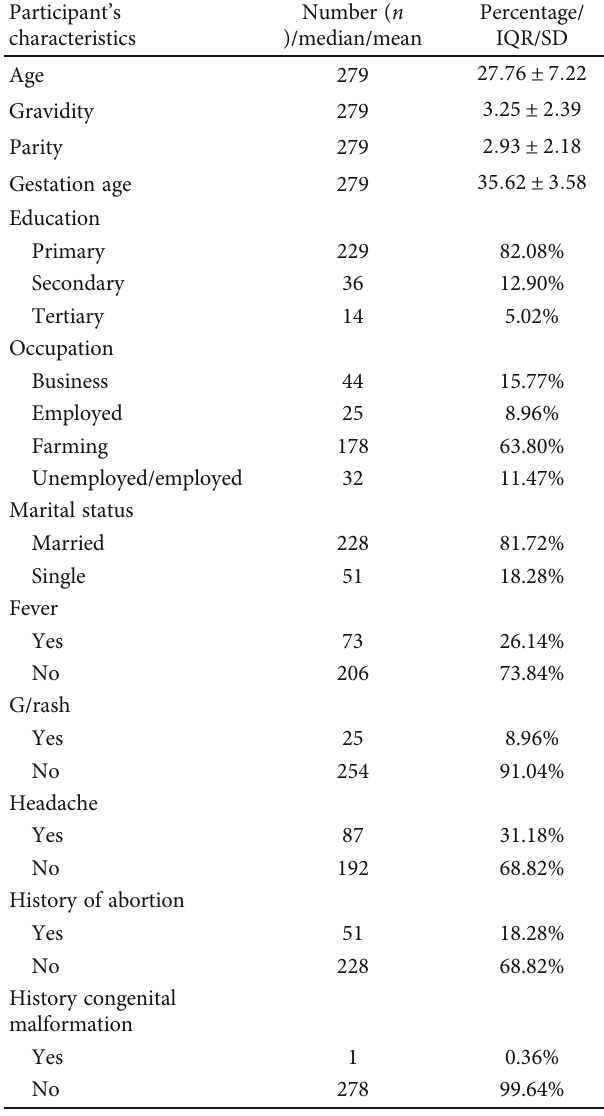
Table 2: Sociodemographic characteristics and obstetrics history of 279 women with macerated stillbirth in Mwanza